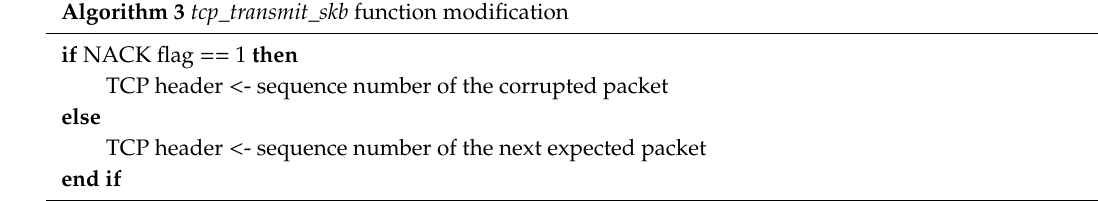
Algorithm 3 tcp_transmit_skb function